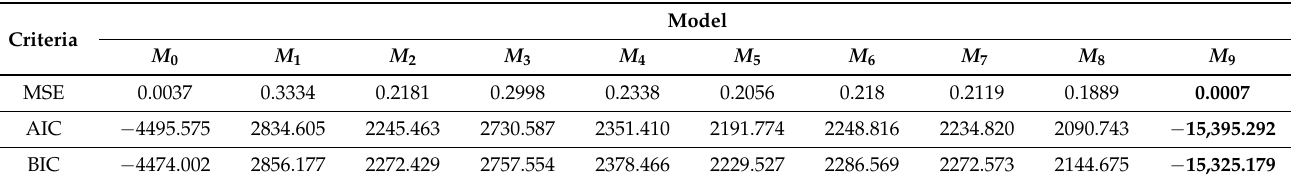
Table 4. The values for the selection criteria of the